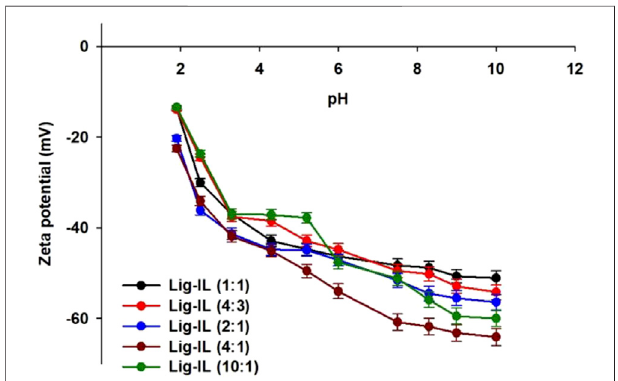
FIGURE 5 | Zeta potential vs . pH for all prepared